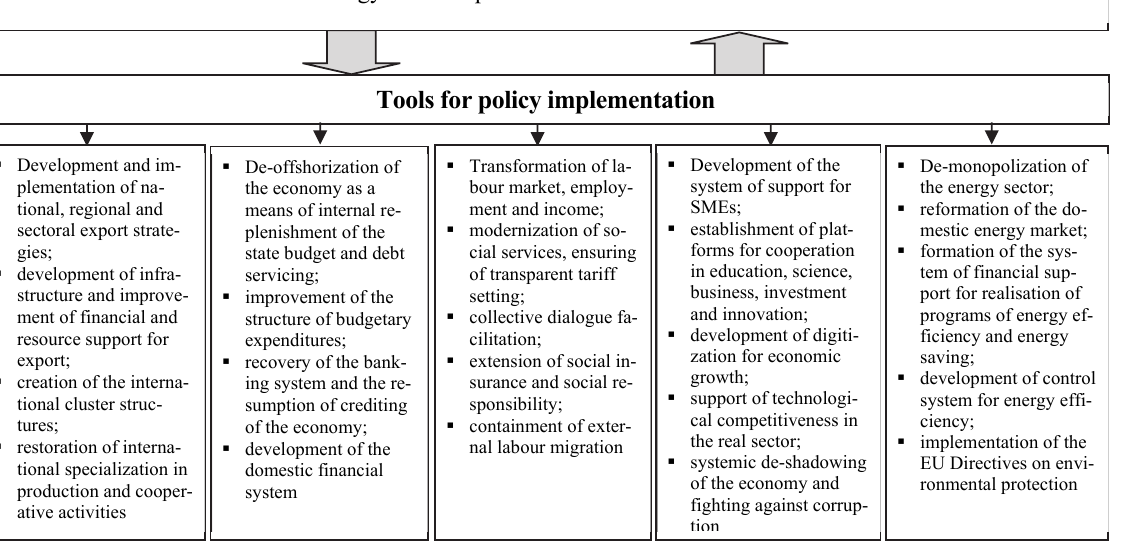
Fig. 5. Strategic priorities, objectives, and tools of the state policy of social and economic development of Ukraine with a focus on convergence and formation of pre-conditions for EU integration